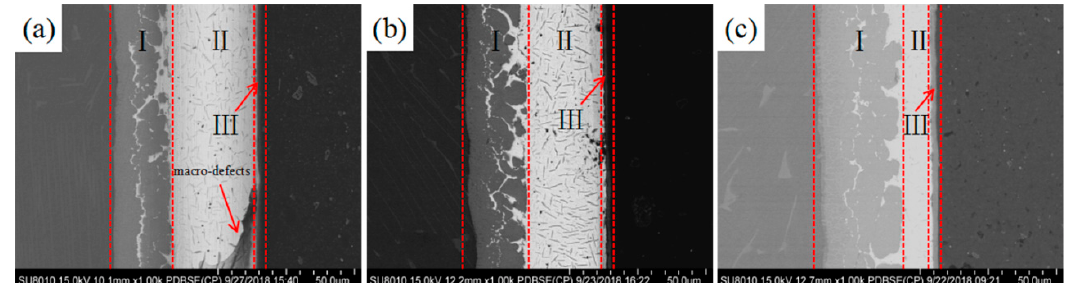
Figure 5. The interfacial microstructures of TiAl/AgCu/Si 3 N 4 brazed joints at different brazing temperatures. ( a ) 1153 K, ( b ) 1173 K, ( c ) 1193 K.